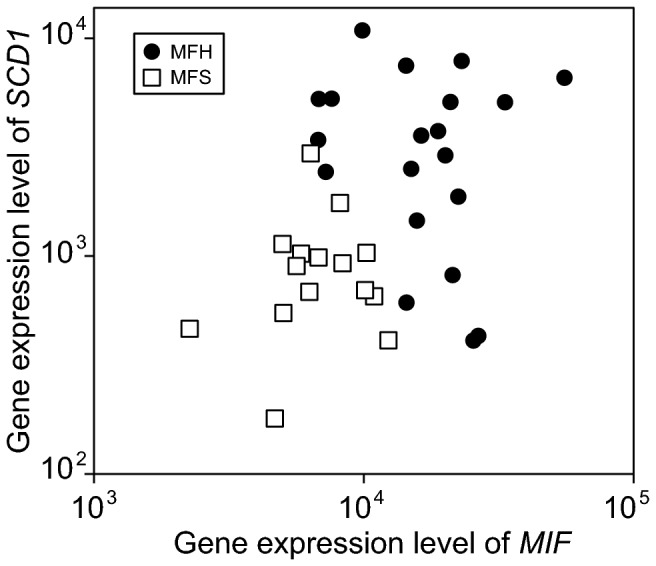
Discrimination between MFH and MFS by using expressions of MIF and SCD1.Open square indicates MFS patient. Filled circle indicates MFH patient.